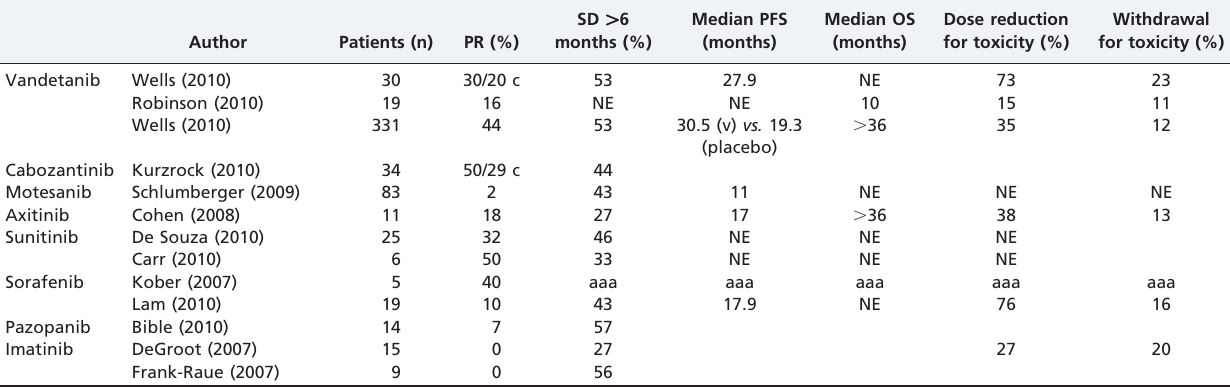
Table 2 - Results obtained in patients with medullary thyroid carcinoma with kinase